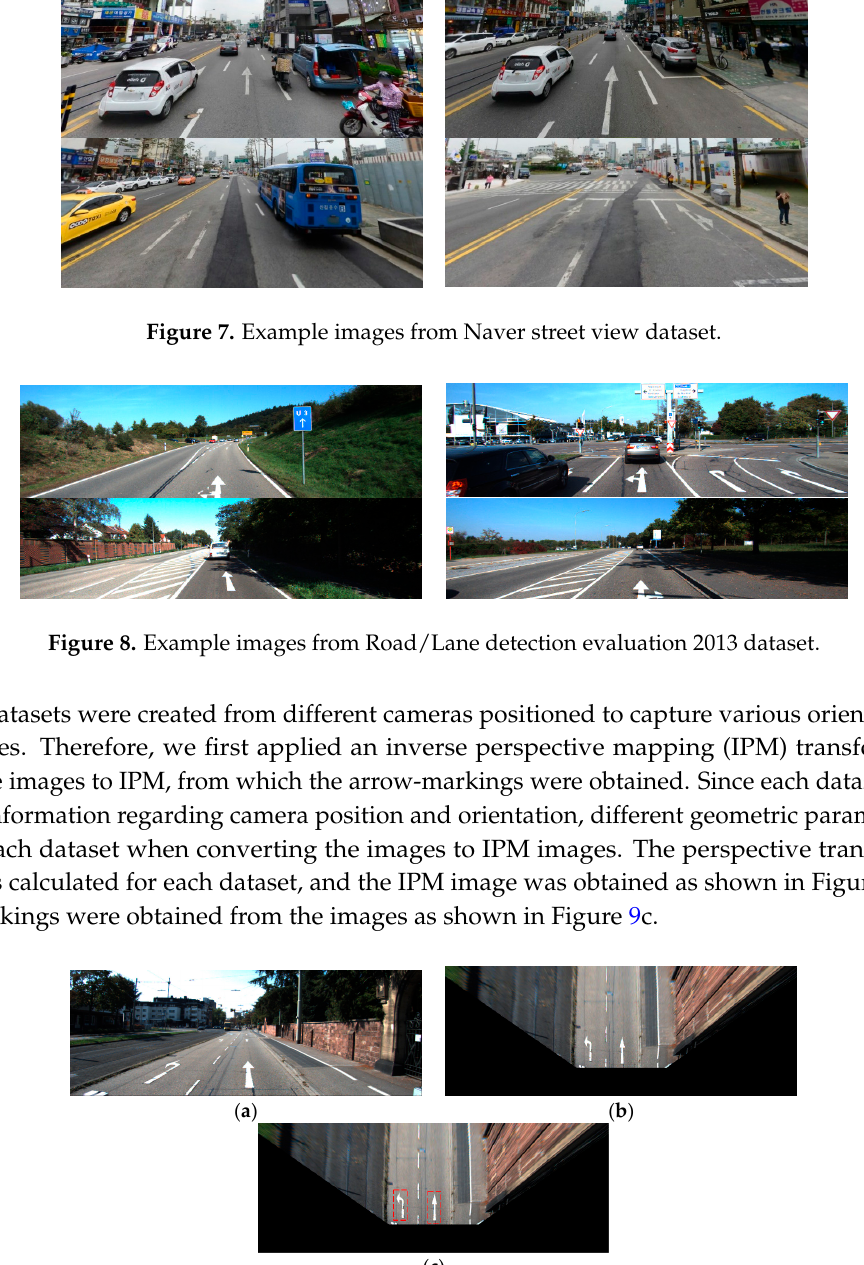
Figure 9. Obtaining the inverse perspective mapping (IPM) image and arrow markings: ( a ) original image; ( b ) IPM transformation; and ( c ) the obtained arrow markings.